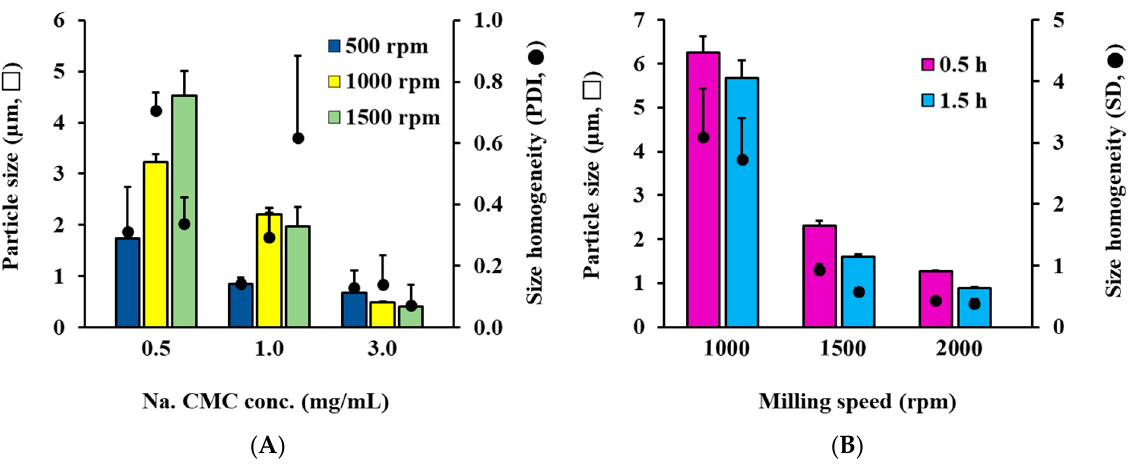
Figure 1. Effect of formulation and fabrication parameters on drug particle size and homogeneity in RTG-loaded injectable crystalline suspension. ( A ) Effect of Na. CMC concentration and bead-milling speed on drug particle size and homogeneity of the AS system. ( B ) Effect of bead-milling speed and milling time on crystal size and homogeneity of the OS system. Notes: The particle size and homogeneity of AS system were determined using dynamic light scattering method. On the other hand, for the RTG-OS, the size of the suspended RTG crystals was determined using a micrometer for 200 randomly selected RTG particles from light microscope images, with difficulty in analyzing hydrodynamic diameter with dynamic light scattering method (Zetasizer Nano ® ).